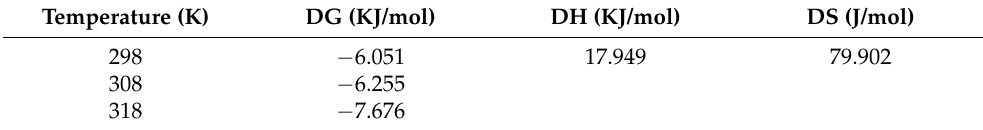
Table 4. Thermodynamic parameters for As(V) adsorption on Magnetic Xerogel Monoliths. Temperature